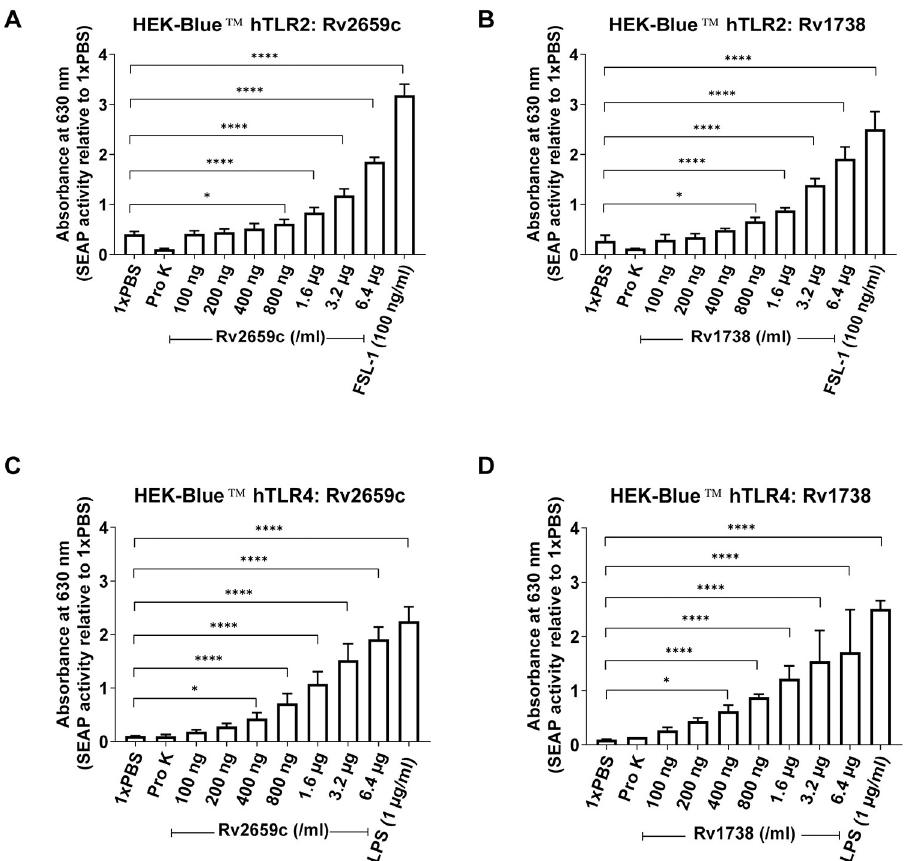
Fig 1. Recognition of recombinant proteins Rv2659c and Rv1738 by hTLR2 and hTLR4. HEK-Blue ™ hTLR2 and HEK-Blue ™ hTLR4 cells were treated with different concentrations (100 ng/ml, 200 ng/ml, 400 ng/ml, 800 ng/ml, 1.6 μ g/ml, 3.2 μ g/ml and 6.4 μ g/ml) of proteins Rv2659c ( A and C ) and Rv1738 ( B and D ) for 16 hours before measuring SEAP production by microplate reader. 1 x PBS and Pro K-digested protein were used as the negative controls, while FSL-1 (100 ng/ml) and LPS (1 μ g/ml) were served as the positive controls for TLR2 and TLR4, respectively. Data are represented as mean ± SD of triplicate experiments (Each was duplicated). One-way ANOVA with Dunnett’s multiple comparison test was used for statistical analysis. p values are represented with asterisk symbols ( � p < 0.05 �� p < 0.01, ��� p < 0.001 and ���� p < 0.0001). maintain Mtb in latency phase, while RpfB incites DCs towards Th1/Th17 cell expansion in a TLR4-dependent pathway [32,33]. However, recognition and interaction of Rv2659c and Rv1738 via TLR2/TLR4 are not yet identified. To examine whether these two dormancy-asso- ciated antigens can be recognized by TLR2/TLR4, HEK-Blue ™ hTLR2 and HEK-Blue ™ hTLR4 (co-transfected human embryonic kidney 293 cells that stably overexpress individual human TLR2, human TLR4 and a reporter signal NF- κ B-inducible SEAP) were employed. We pro- duced recombinant Rv2659c and Rv1738 proteins in an E . coli system free of endotoxin con- tamination. NF- κ B reporter cells suspended in HEK-Blue ™ detection medium were treated with various concentrations of these two proteins (100 ng/ml, 200 ng/ml, 400 ng/ml, 800 ng/ ml, 1.6 μ g/ml, 3.2 μ g/ml and 6.4 μ g/ml). TLR2/TLR4 activation was assessed by measuring NF- κ B-dependent SEAP, reflected by colorimetric shift and higher absorbance of detection media. Upon treatment, proteins Rv2659c and Rv1738 induced significantly greater NF- κ B-depen- dent SEAP activity in a dose-dependent manner (Fig 1). Increased absorbance from HEK- Blue ™ hTLR2 and hTLR4 cells incubated with Rv2659c (initiated at 800 ng/ml and 400 ng/ml,